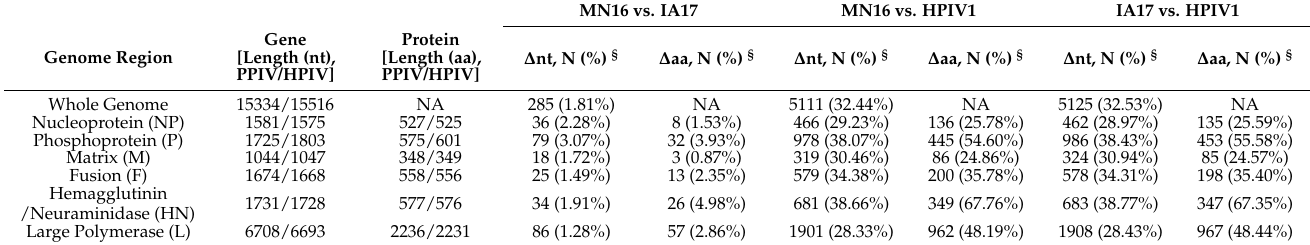
Table 3. Gene-level pairwise % differences between MN16, IA17, and HPIV1 virus isolates used in this study. MN16 vs. IA17 MN16 vs.